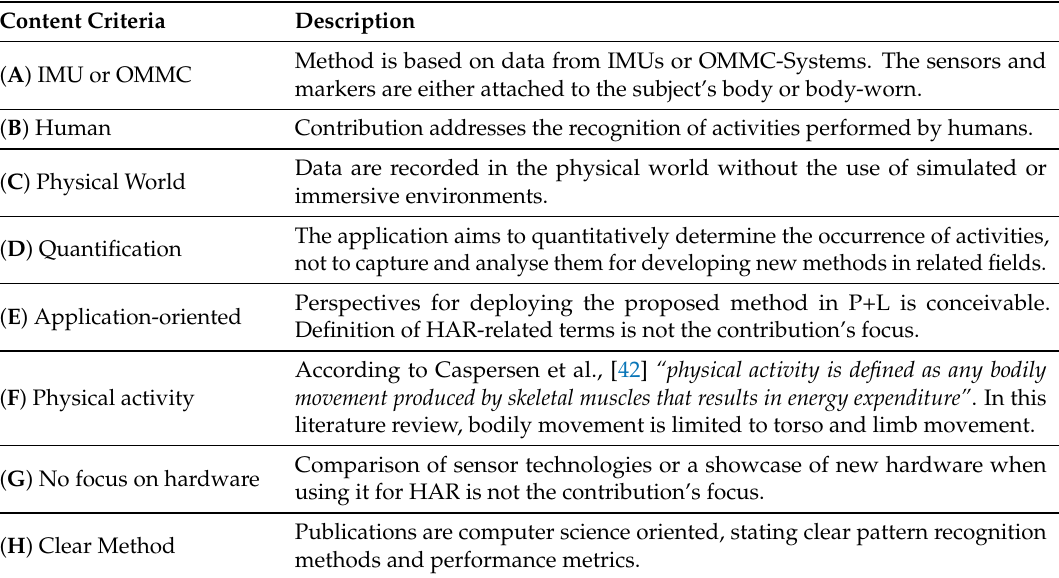
Table 3. Content Criteria for selection